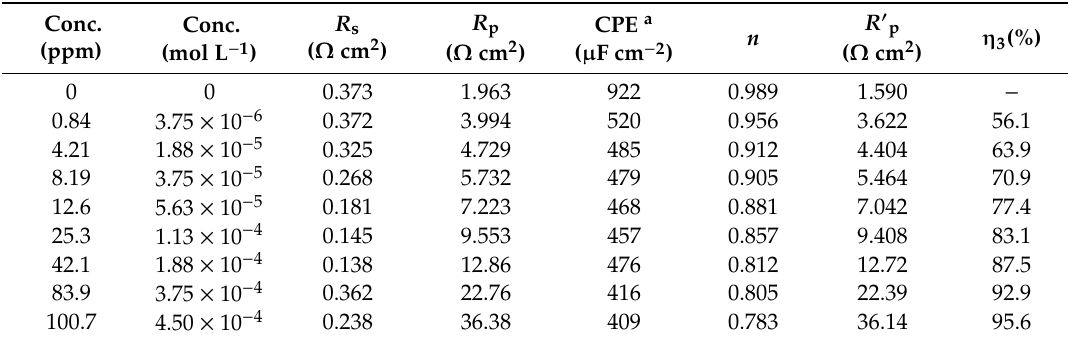
Table 6. Impedance parameters for the corrosion of a mild steel sample in 1 M HCl solutions containing corrosion inhibitor 7 at 333